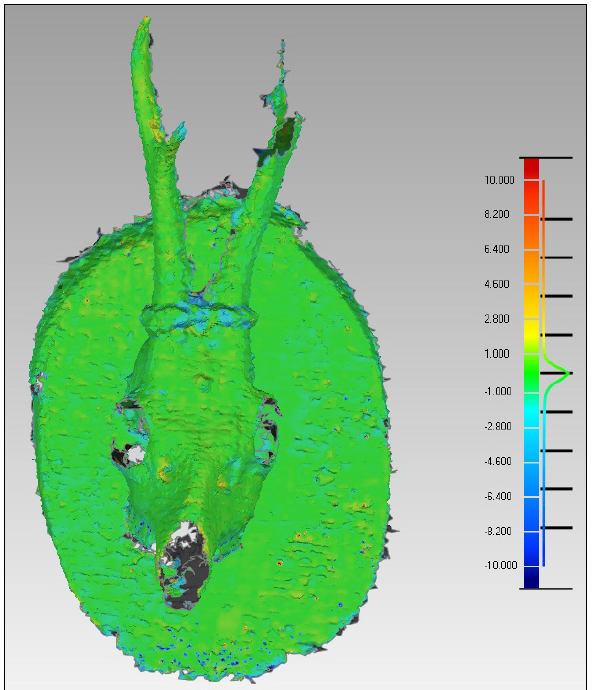
Figure 6. Deviations comparison of the DAVID model to the ARTEC model, threshold ± 10 mm